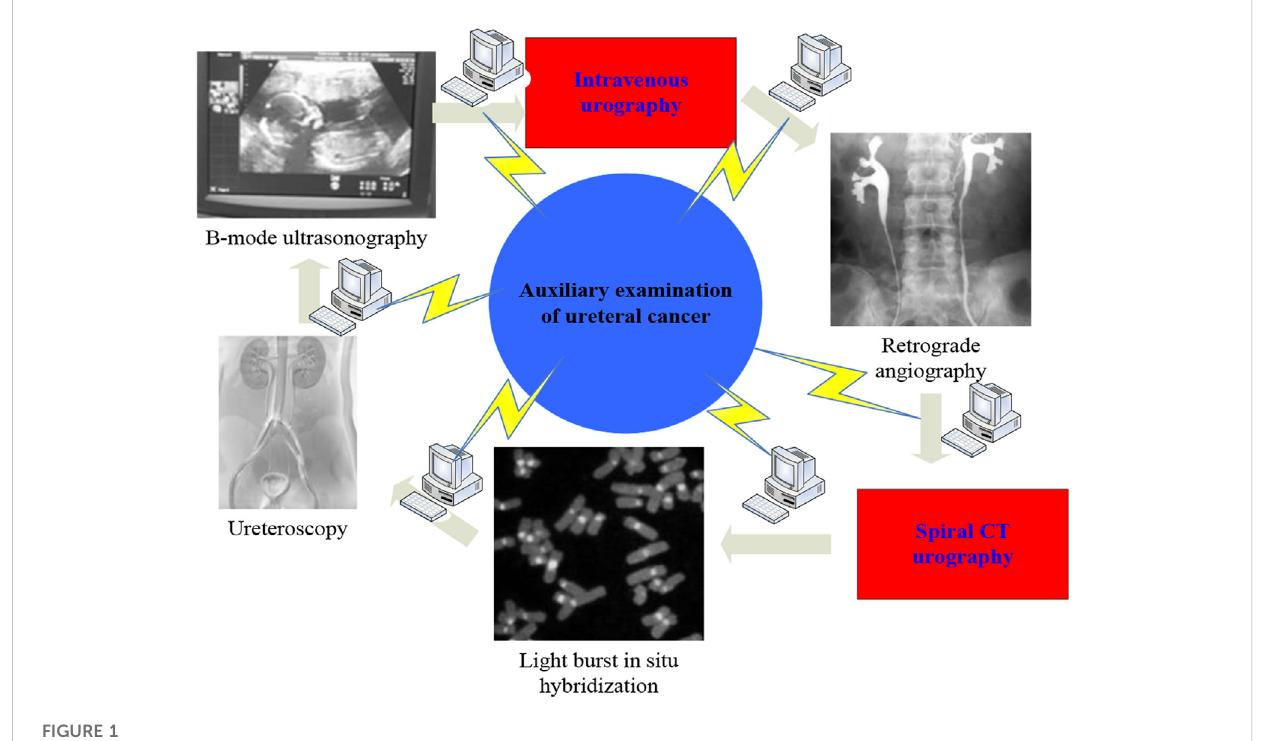
FIGURE 1 Auxiliary examination for ureteral